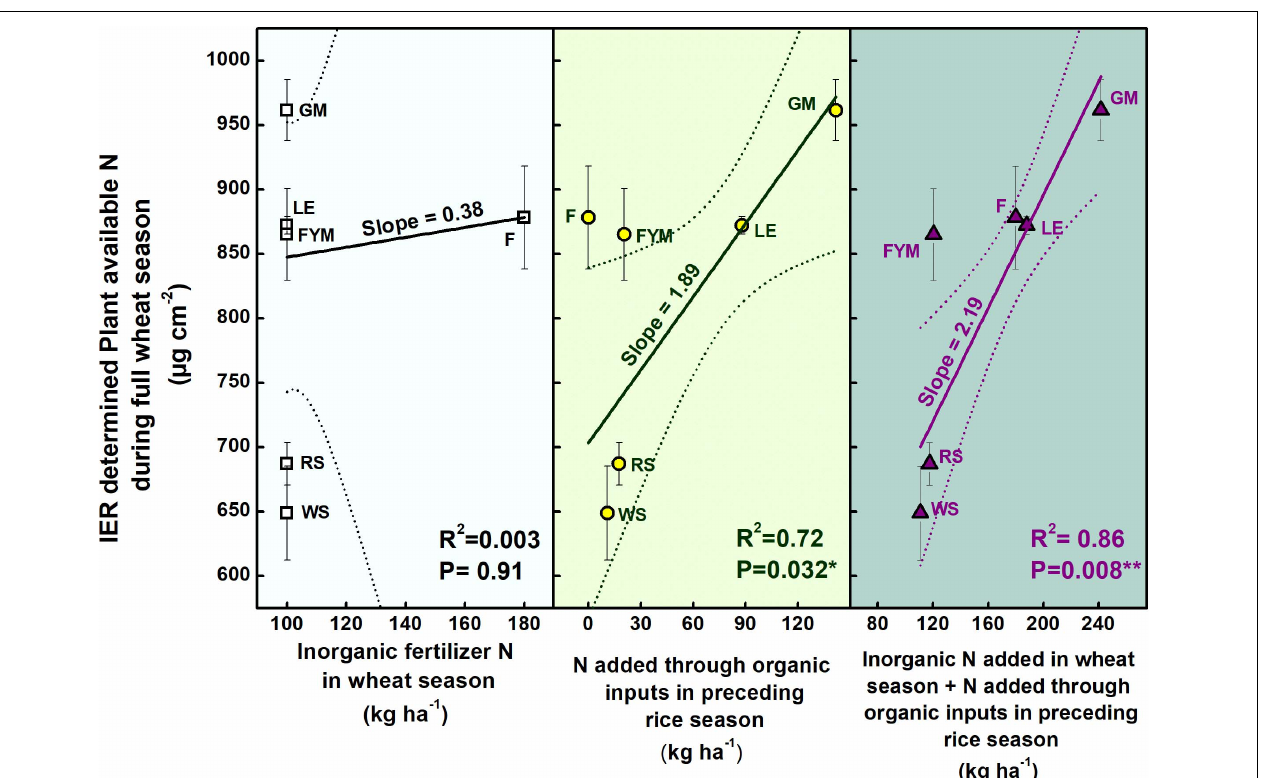
FIGURE 4 | Relations between nitrogen (N) applied through organic and inorganic sources and IER (ion exchange resin) determined N availability during wheat ( Triticum aestivum ) growing season. Error bars denote ± 1SD. Treatments are described in Figure 2 legend.